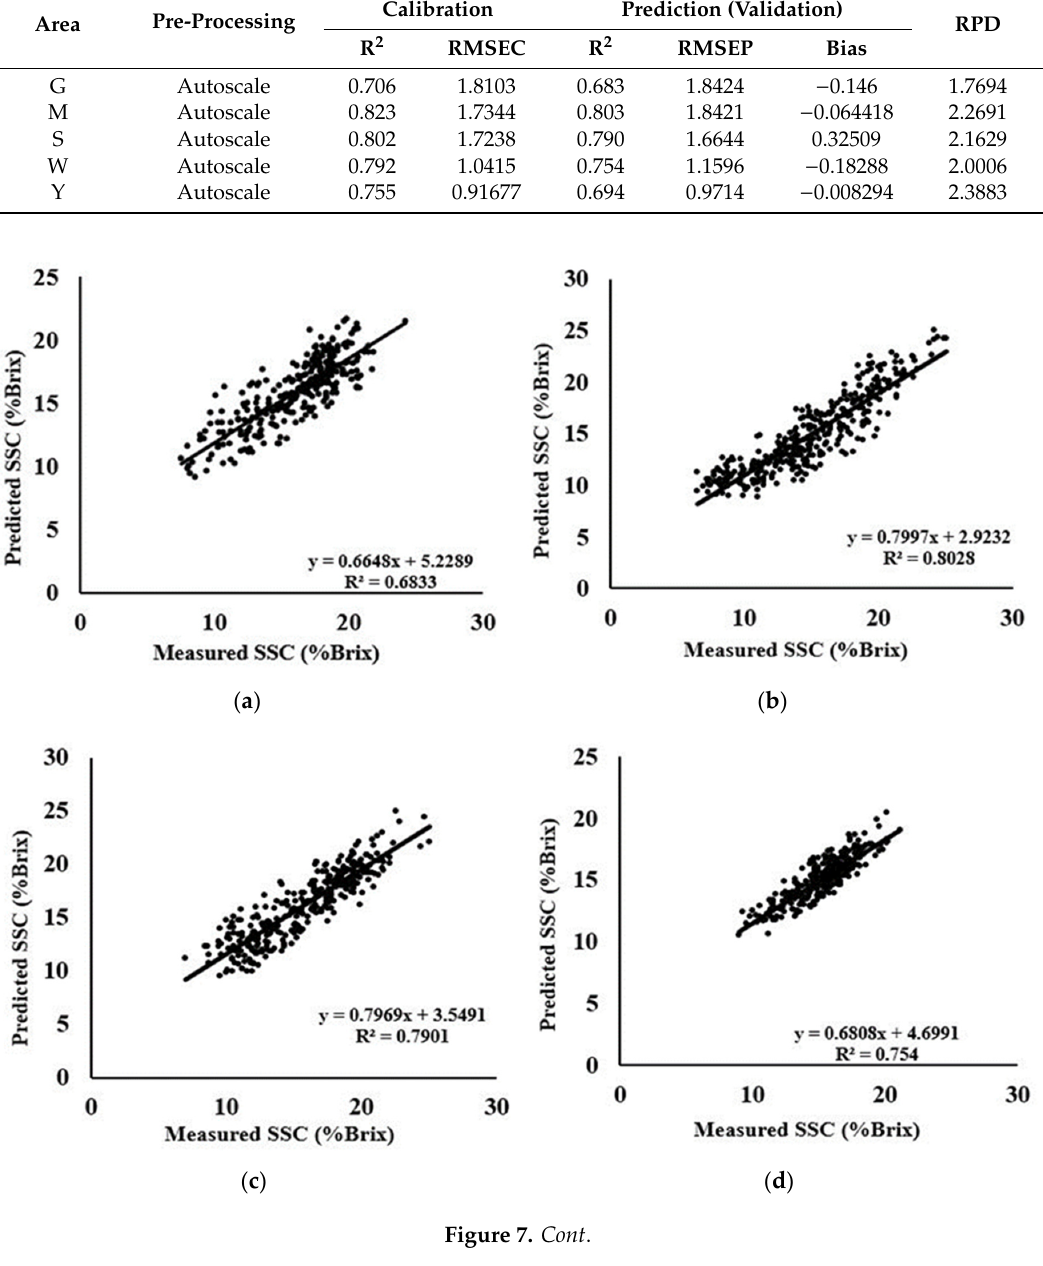
( e ) Figure 7. Scatter plots of measured versus predicted SSC using SVM-R method with Autoscale preprocessing ( a ) G; ( b ) M; ( c ) S; ( d ) S; and ( e ) Y area, respectively. 3.8. SVM Models for the Prediction of SSC- Species and Combine Dataset Table 10 presents the best predicted results of SVM-R analysis obtained from the species, and results with the other preprocessing techniques are presented in the supplementary material (see Table S4). Table 11 presents the combine dataset results with all the preprocessing techniques. For the species table, the best-predicted correlation coefficient was obtained from Autoscale preprocessing for species A, C, and D with the value of 0.79, 0.73, and 0.71, respectively. Another species Gb showed poor prediction correlation of 0.62. In addition, Gb relies on MSC + SNV preprocessing with higher predictability, the lowest RMSEP and higher RPD among preprocessing techniques. The second derivative and the preprocessing MSC on second derivative data yielded poor results and followed the same trend for each area.